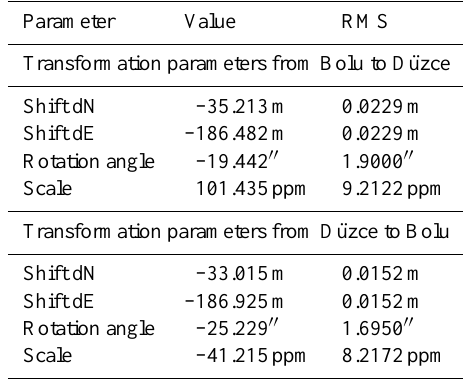
Table 1. Transformation from Bolu to D¨uzce and D¨uzce to